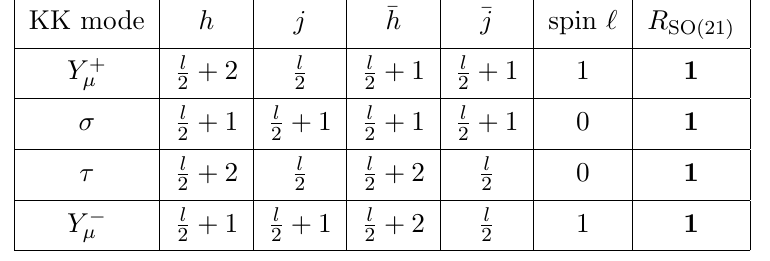
Table 2 . Kaluza-Klein modes from the spin-1 multiplet (cid:6) l , l = 0 ; 1 ; : : : .